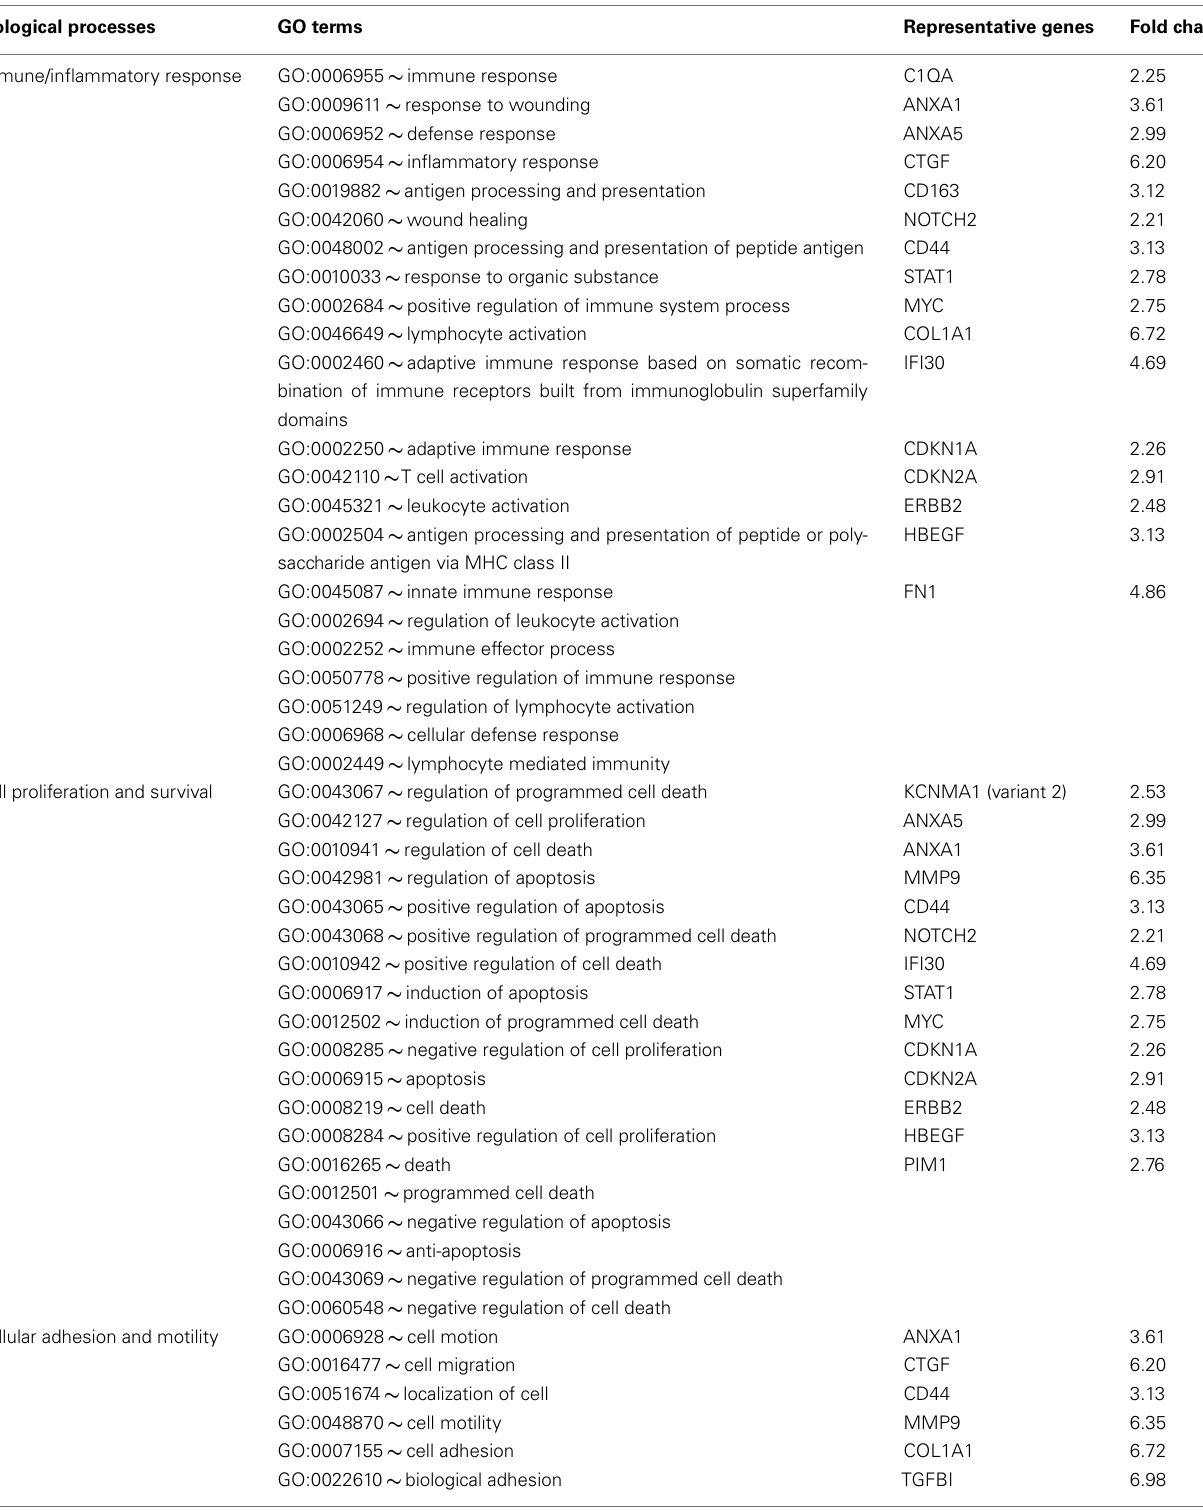
Table 2 | Statistically significant biological processes, associated to the upregulated genes only, represented by DE GO terms in our cohort of glioma